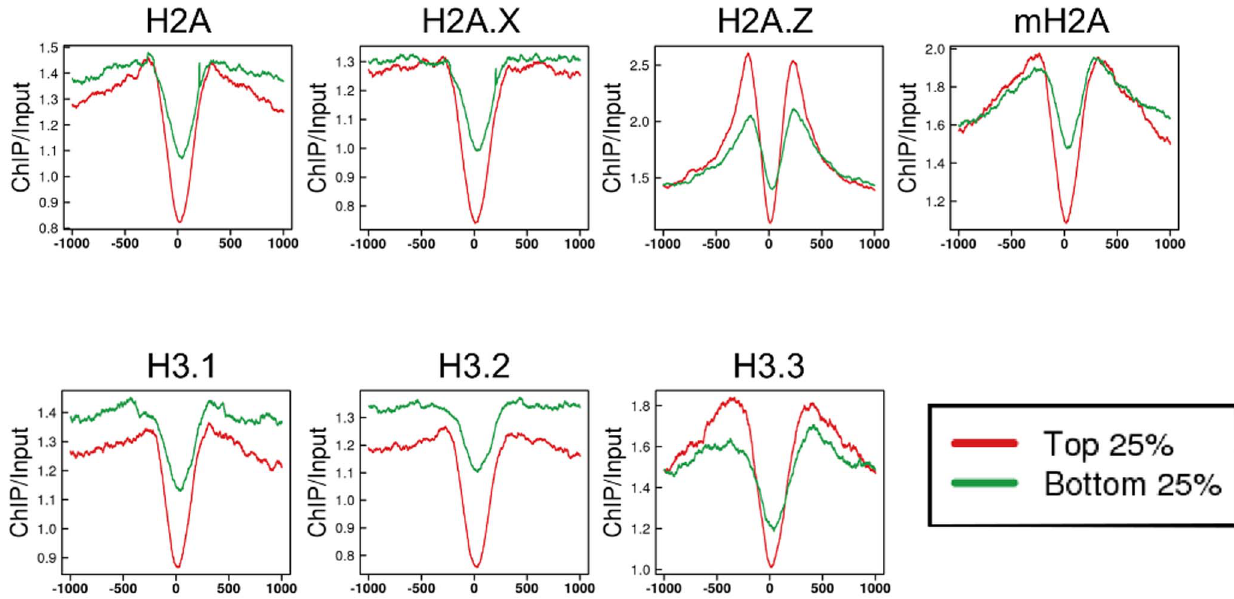
Figure 4. Enrichment of histone variants in insulator regions. Profile of the average enrichment of H2A (upper) and H3 (lower) variants in insulator regions defined as CTCF binding sites in genomic regions except for gene body obtained from Chen’s ChIPseq data [35]. The 0 position is the center of the CTCF binding site. CTCF binding sites were ordered based on the amount of CTCF bound; the average enrichment of histone variants in the top (red) and bottom (green) 25% is